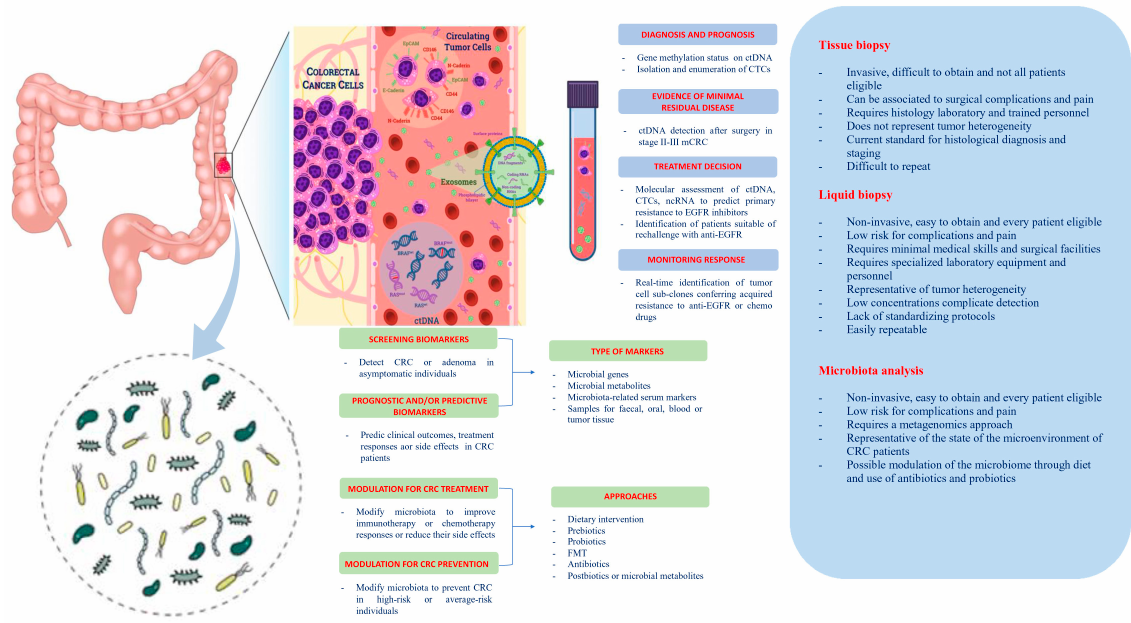
Figure 1. Potential clinical applications related to liquid biopsy and gut microbiota in colorectal cancer. Circulating tumor cells (CTCs), circulating tumor DNA (ctDNA), non-coding RNA (ncRNA), and exosomes are promising liquid biopsy markers for colorectal cancer with multiple potential advantages compared to tissue biopsy. CTCs from colorectal cancer (CRC) can be shed from the primary tumor into the bloodstream, which also contains ctDNA released from tumor tissue through apoptosis, necrosis, and secretion, as well as circulating normal DNA released from healthy tissue. NcRNAs (miRNAs and lncRNAs) encapsulated by exosomes can be actively secreted into the extracellular fluid by various types of cells in the tumor or passively released due to the apoptosis and necrosis of tumor cells and can eventually be found in the circulation. Besides liquid biopsy, several potential clinical applications for harnessing the gut microbiota in CRC include development of screening, prognostic and predictive biomarkers, and microbiota modulation for CRC prevention and treatment. FMT, fecal microbiota